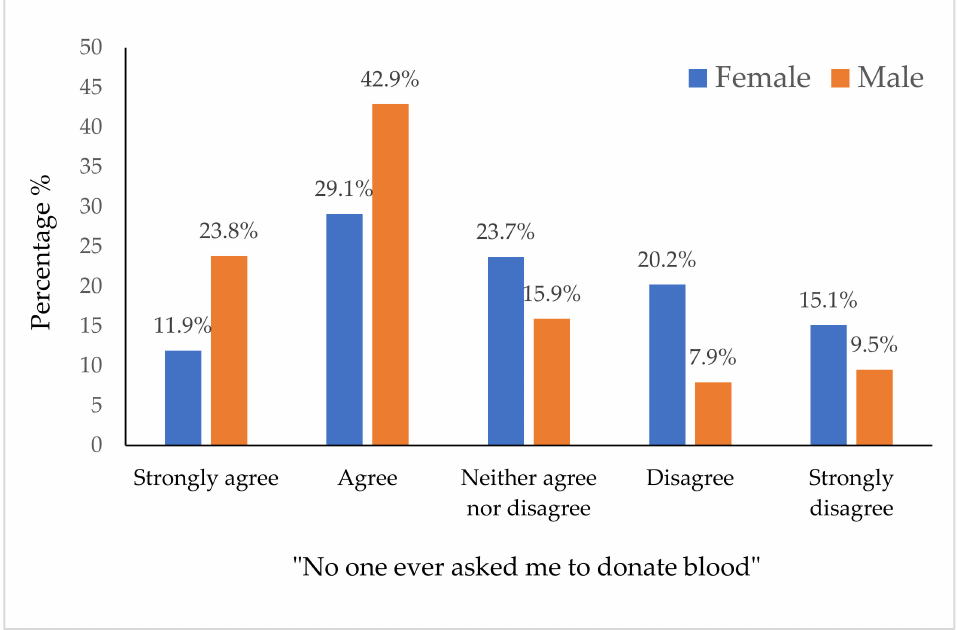
Figure 2. Association between gender and blood donation barriers (“No one ever asked me to donate blood”) ( n =